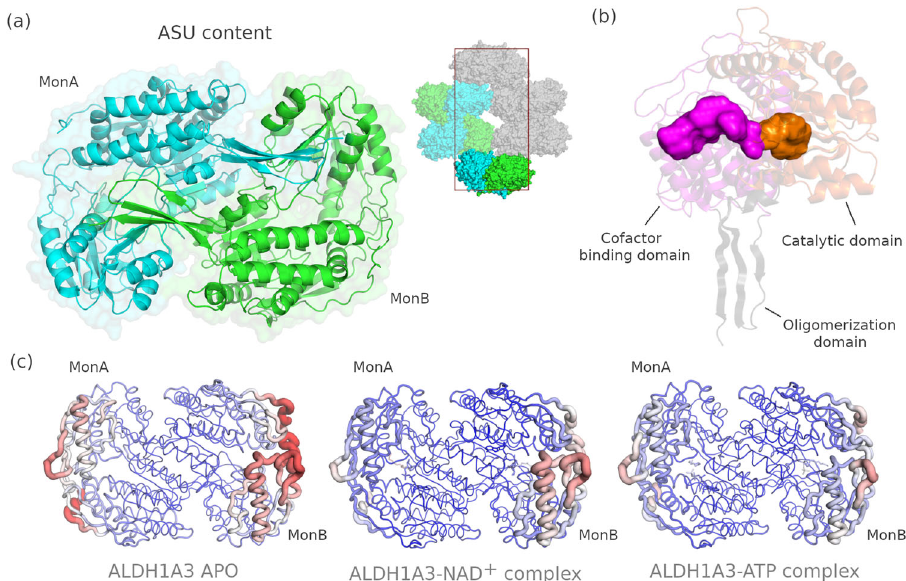
Fig. 1 Structural description of ALDH1A3. a Half ALDH1A3 homotetramer contained in the asymmetric unit (left). The homotetrameric biological form appears in the crystallographic unit cell (right sub fi gure) after applying the symmetries of the space group. b Binding pockets in the cofactor (magenta) and catalytic (orange) domains. c Ribbon representation of the three described ALDH1A3 structures (PDB codes 7QK7, 7QK8 and 7QK9, respectively). The ribbon radius is scaled and normalized to the maximum B-factor reached in the ALDH1A3 apo structure. Residues in the main chain marked in red show the highest B-factor values, while those marked in blue show the lowest